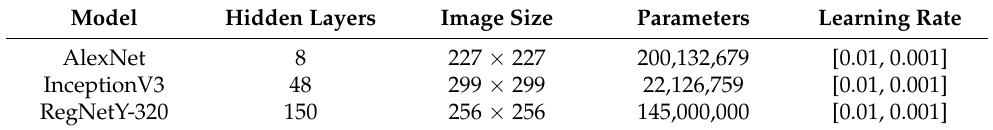
Table 1. Characteristics of the CNNs’ architectures in the proposed framework. Model Hidden Layers Image Size Parameters Learning Rate AlexNet 8 227 × 227 200,132,679 [0.01, 0.001] InceptionV3 48 299 × 299 22,126,759 [0.01, 0.001] RegNetY-320 150 256 × 256 145,000,000 [0.01, 0.001]